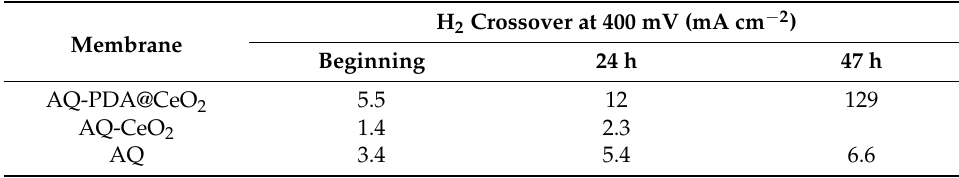
Table 4. Hydrogen crossover for the indicated membranes at 80 ◦ C and 50%